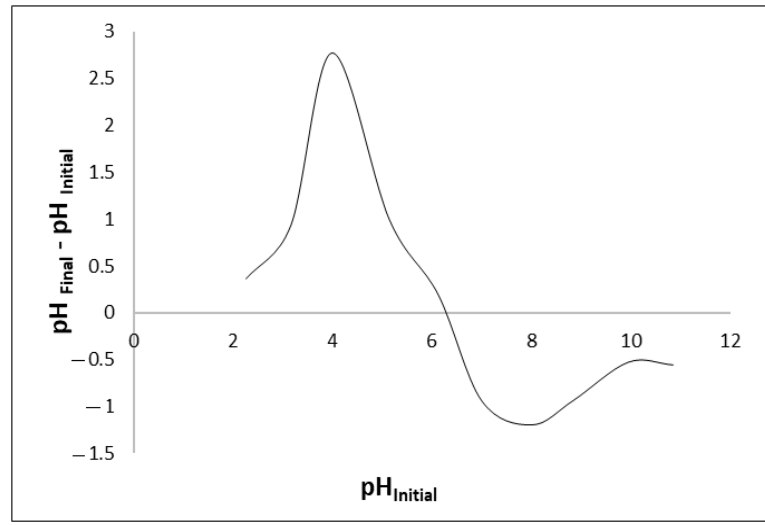
Figure 4. A graphical plot and calculation of the point zero of charge of PFPB.